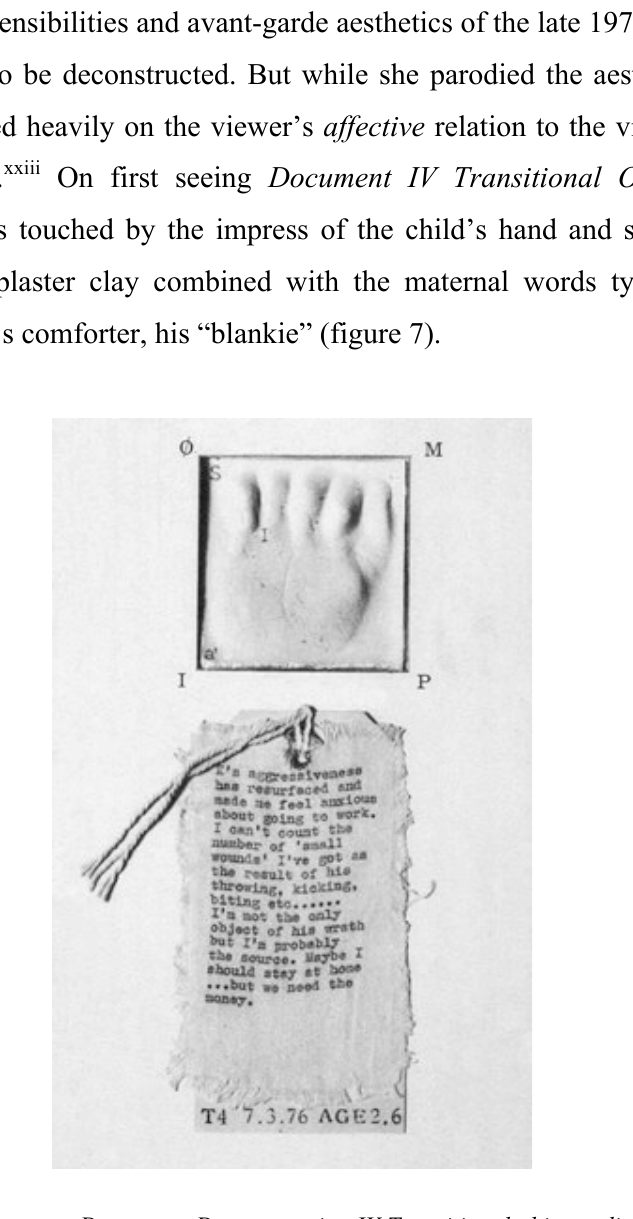
Figure 7: Mary Kelly Post-partum Document, Documentation IV Transitional objects, diary and diagram, 1976. Detail, 11 x 14 ins. mixed